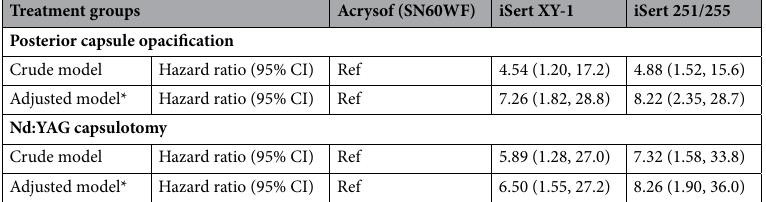
The hazards of PCO and Nd:YAG capsulotomy were compared among the Acrysof SN60WF, iSert XY-1, and iSert 251/255 groups using mixed-effects Cox proportional hazards models (Table 3). The hazards of PCO were higher in the iSert XY-1 and iSert 251/255 groups than in the Acrysof SN60WF group. Correspondingly, the hazard of Nd:YAG capsulotomy was higher in the iSert XY-1 and 251/255 groups than in the Acrysof group.